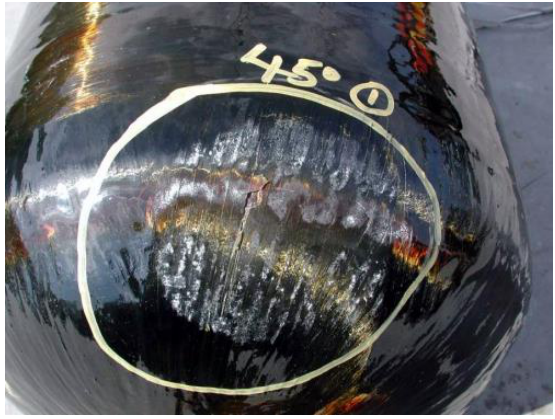
Fig. 1. The effects of the impact test of the CNG composite tank [12]